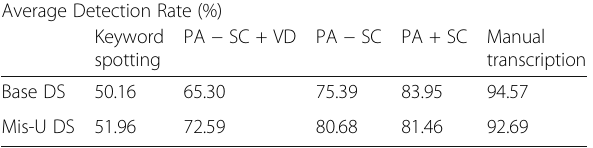
Table 4 Comparison of DS detection performances for the proposed approach using the verification data, the proposed approach with/without sentence clustering, and manual transcription